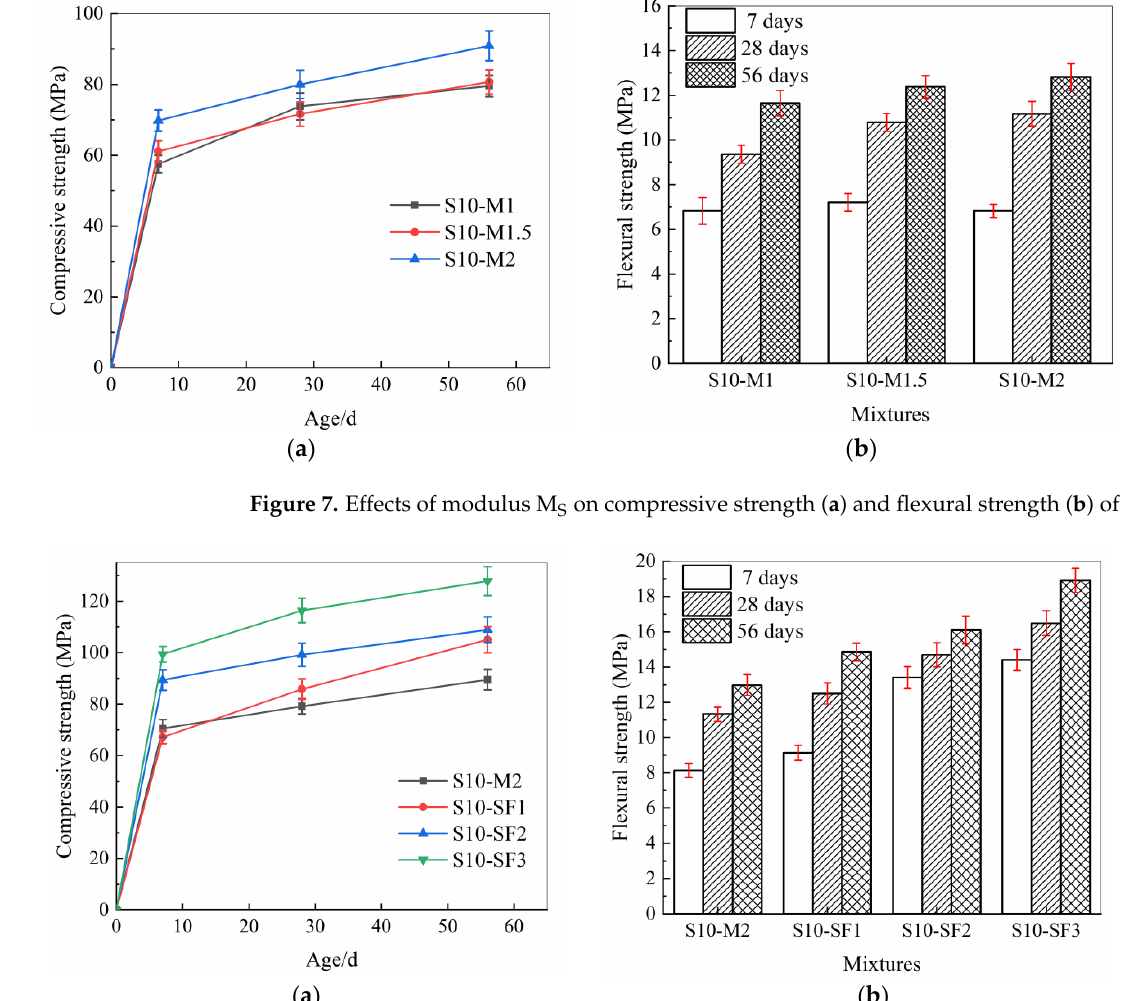
Figure 7. Effects of modulus M S on compressive strength ( a ) and flexural strength ( b ) of AASSC.